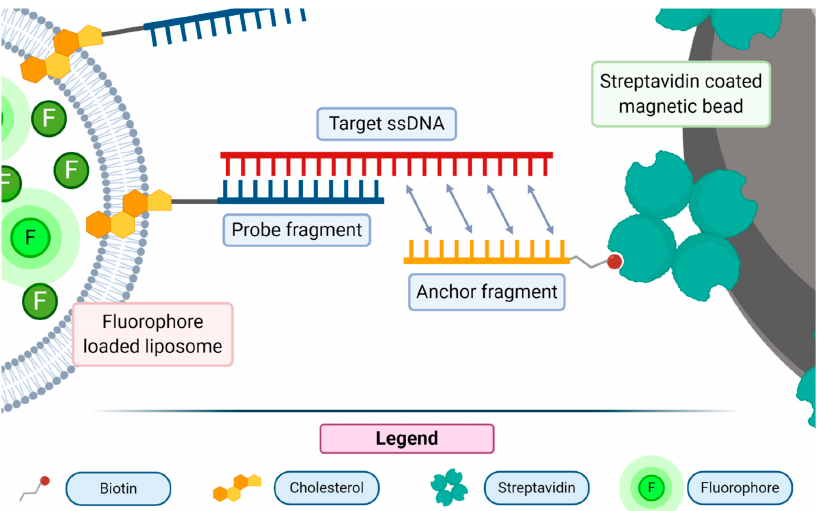
Figure 6. Sandwich hybridization assay: an anchored single-stranded DNA probe is used to selectively and specifically interact with the nucleic acid sequence of interest. Dye encapsulating liposomes, carrying on their surfaces a second probe, complementary to the second portion of the target nucleic acid, are responsible for the anchoring step, yielding the “sandwich” type association. Upon washing out the unbound liposomes, the bound ones are quantitatively assessed upon the release of their fluorescent payload. Figure inspired by [57]. The unbound liposomes were then washed away and the bound ones were disrupted with a detergent molecule (Triton-X100). The released fluorescent dye was then analyzed with a